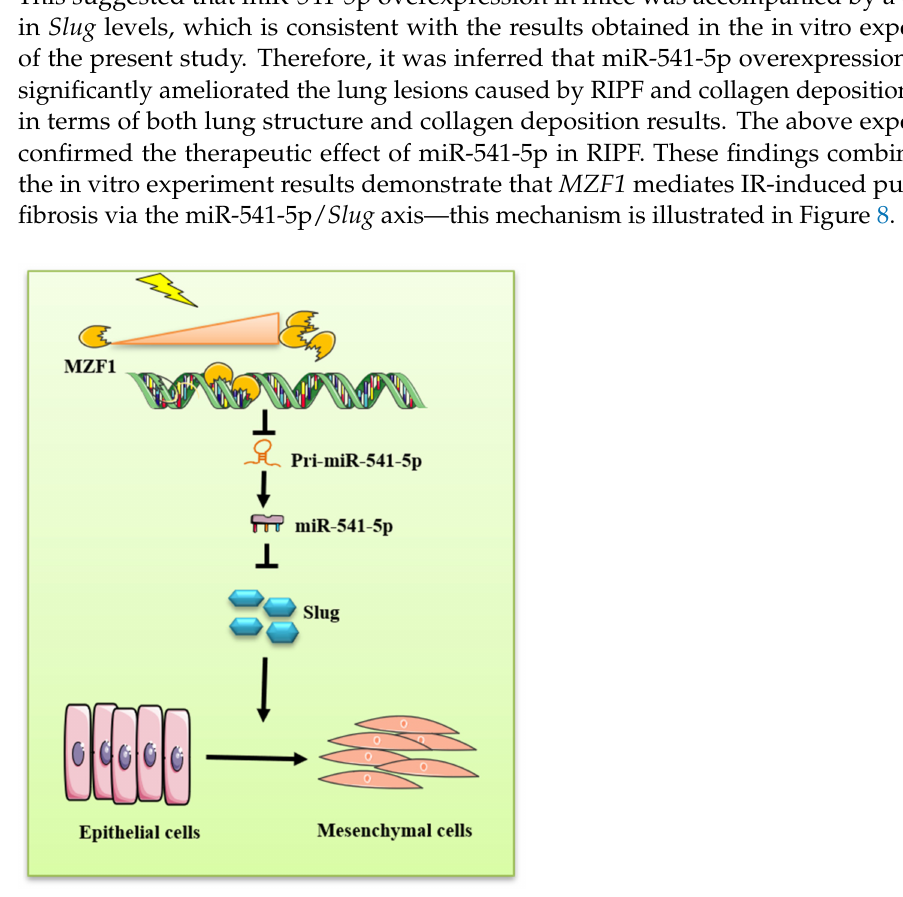
Figure 8. Mechanistic diagram illustrating the functioning of miR-541-5p as a promoter of EMT under IR conditions. IR activated the transcription factor MZF1 , thereby increasing its levels. The increased MZF1 could bind to the promoter region of miR-541-5p, thereby inhibiting the production of pri-miR-541-5p, which consequently reduced the levels of miR-541-5p. With the reduction in the miR-541-5p levels, the silencing effect on the downstream gene Slug was diminished, which consequently induced the EMT